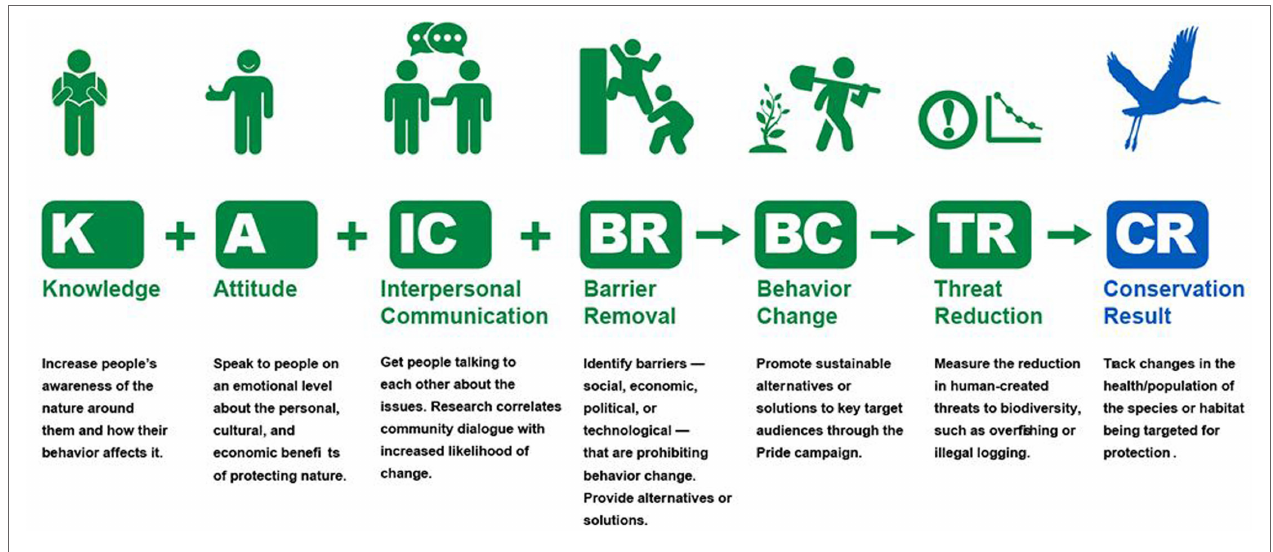
FigUre 1 | Rare’s theory of change